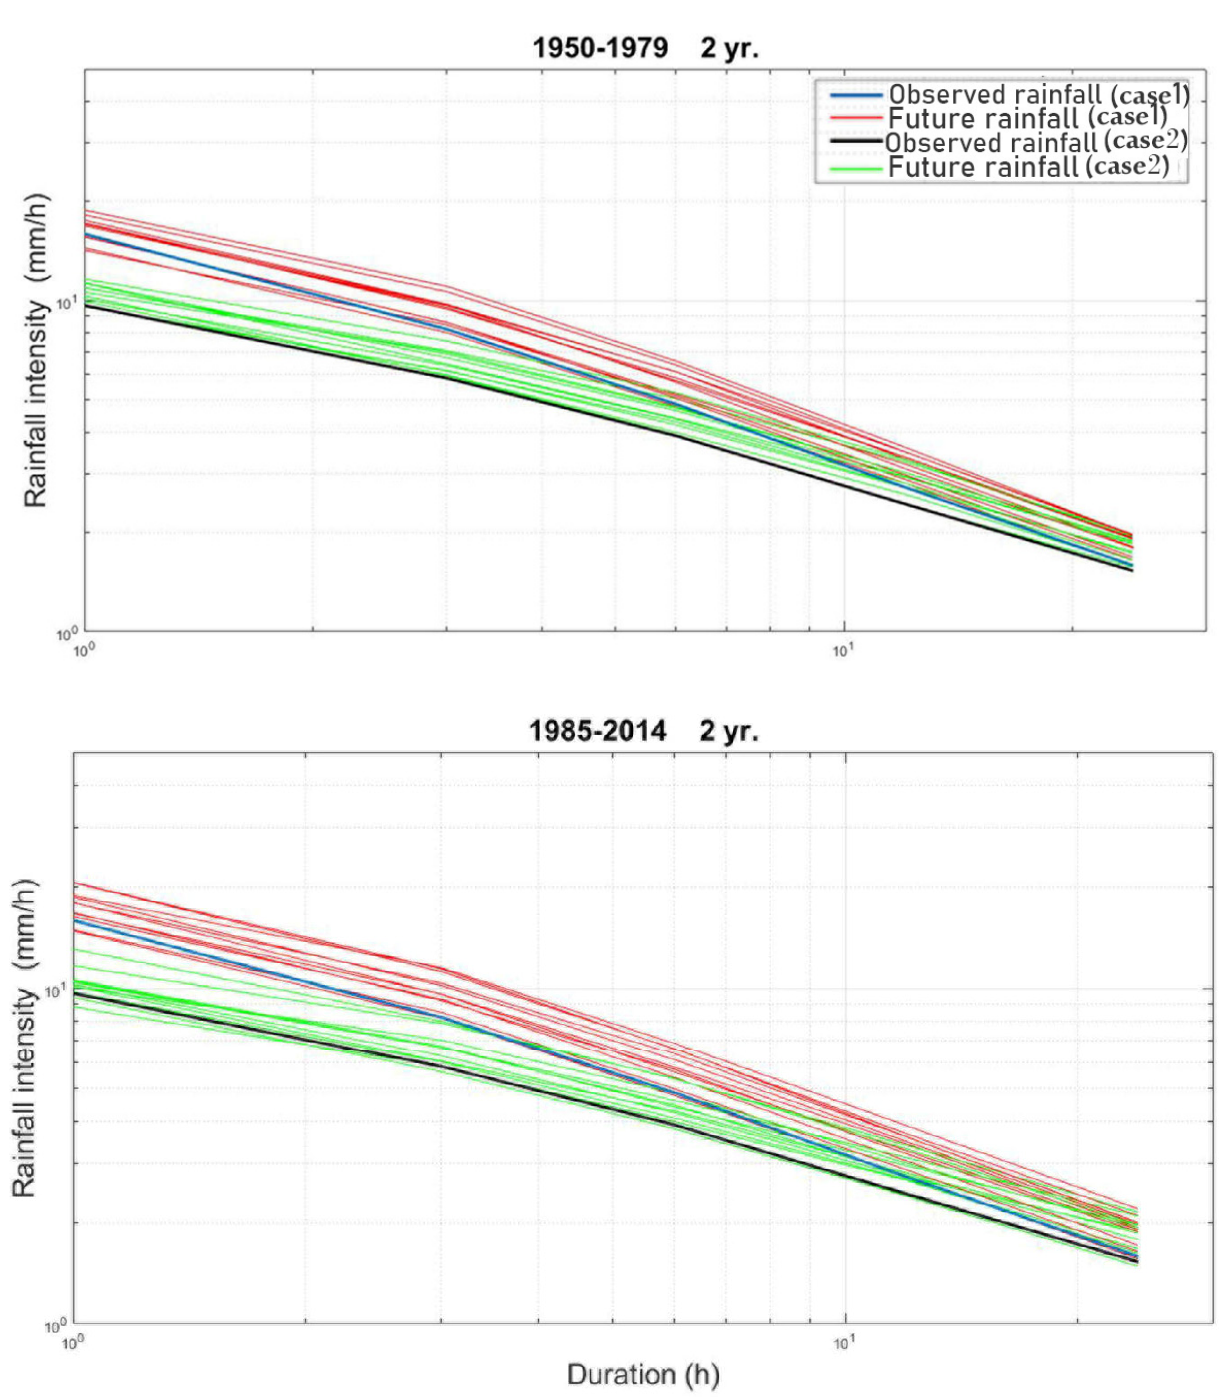
Figure 3. IDF curves for the current and future climate based on the 2 cases of rainfall disaggregation for the first and last reference periods. The two subplots are for the first return period and for 5 rainfall durations.